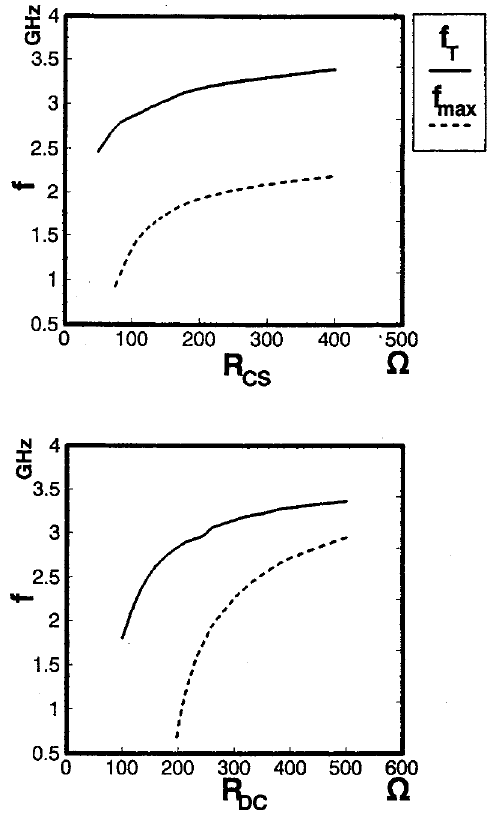
FIGURE 9 The dependence of R DC , R CS on